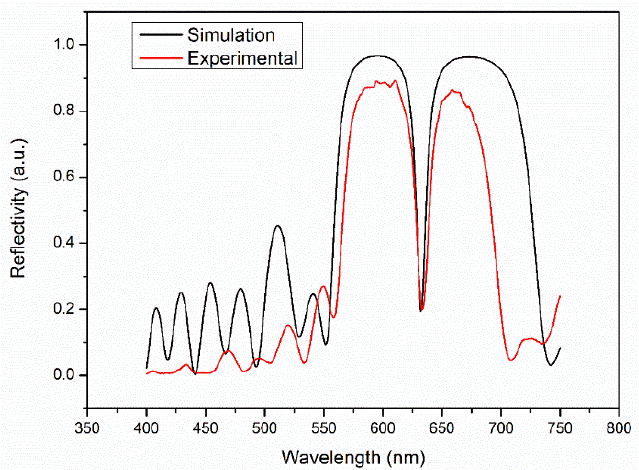
Figure 2. Comparison of PSM reflection spectra from the experimental results and theoretical sim- ulations.